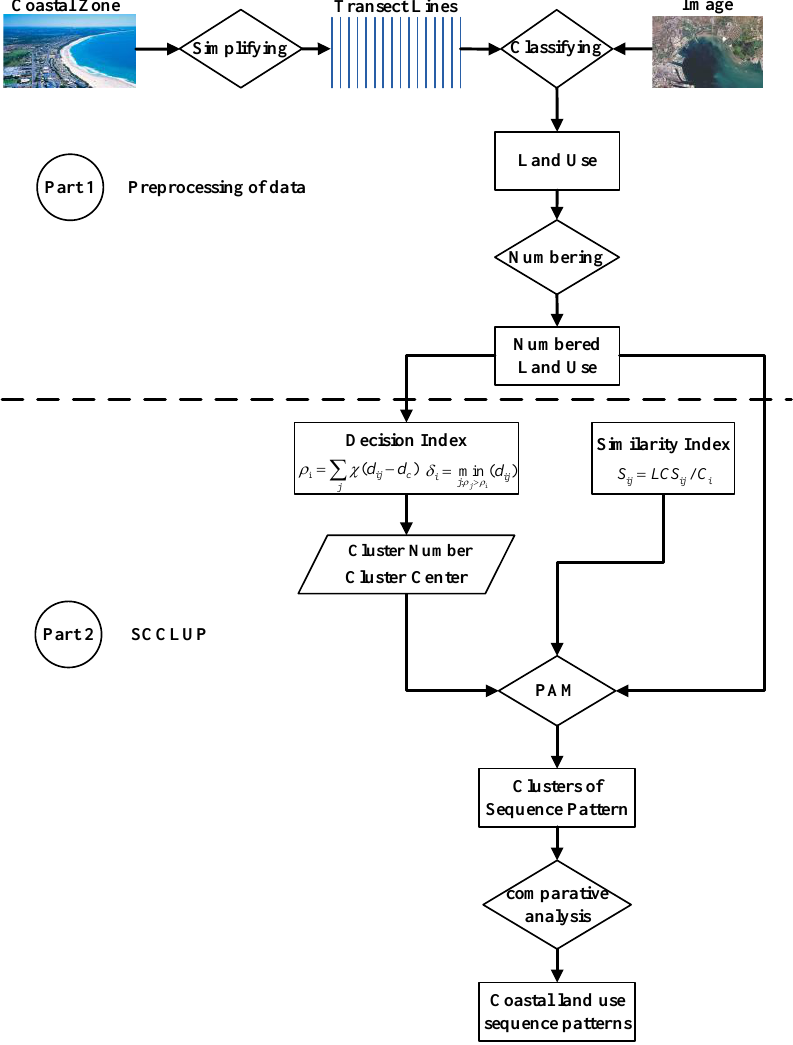
Figure 1. The overall framework of the methodology.